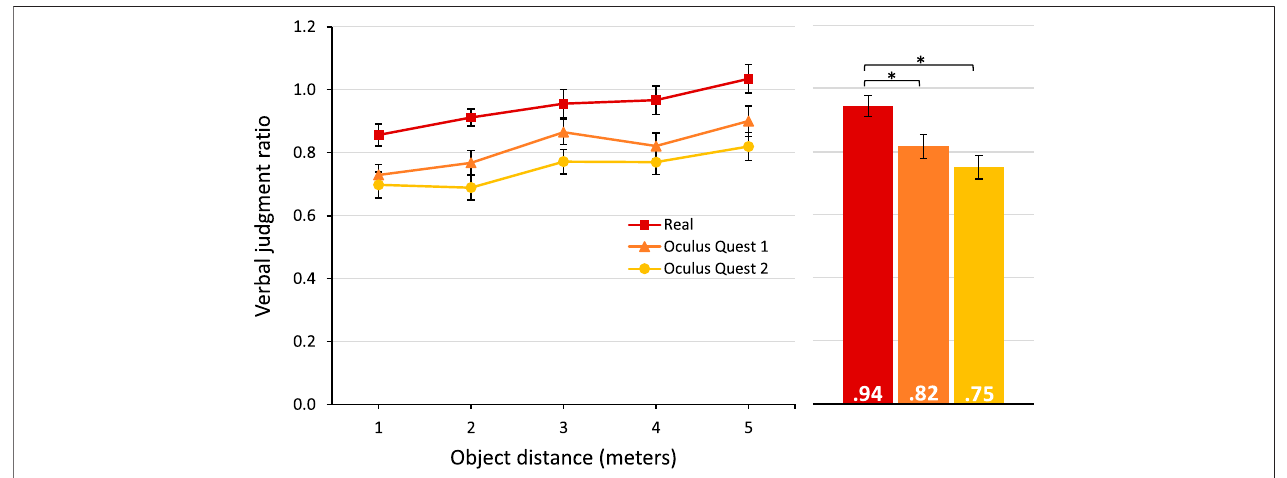
FIGURE 2 | Average verbal distance judgments expressed as a ratio of object distance. Data are plotted as a function of object distance (line graph, left), and also averaged across object distance (bar graph, right). Error bars represent ± one SEM. * p < 0 .05.